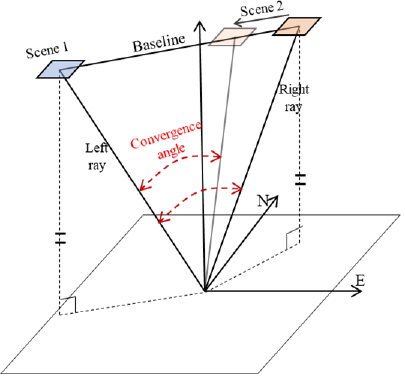
Figure 13. Example of convergence